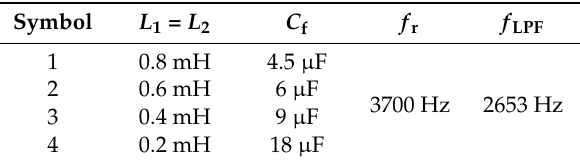
Table 4. LCL parameters for comparison.